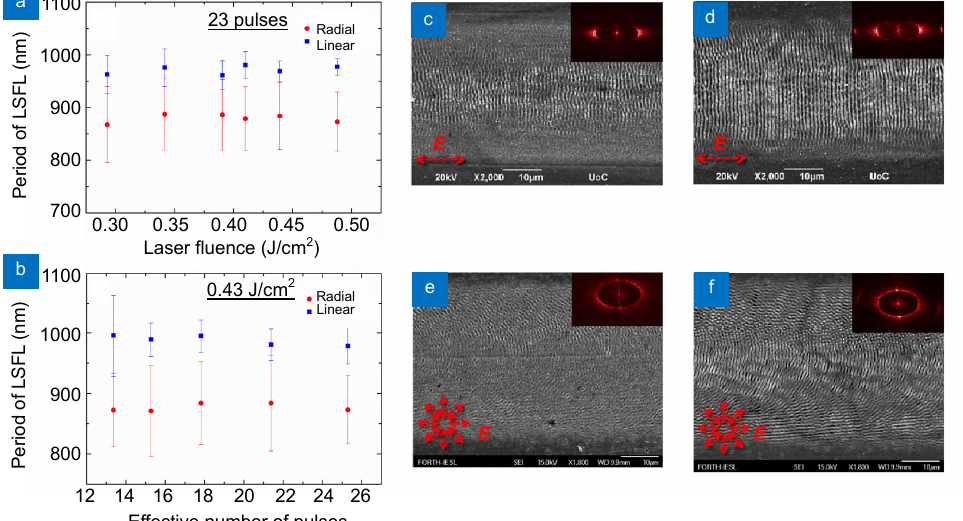
Fig. 2 | LSFL periodicity dependence on the laser fluence (a), and the effective number of pulses (b), for linearly (squares) and radially (circles) polarized fs beams. Top-view SEM images of areas produced upon irradiation using linearly (c,d) and radially (e,f) polarized fs beams. The images shown in (c) and (e) correspond to non-uniform areas, whereas those in (d) and (f) to areas obtained using optimized irradi- ation conditions. The red arrows depict the electric field polarization state. The 2D-FFT patterns corresponding to each area are